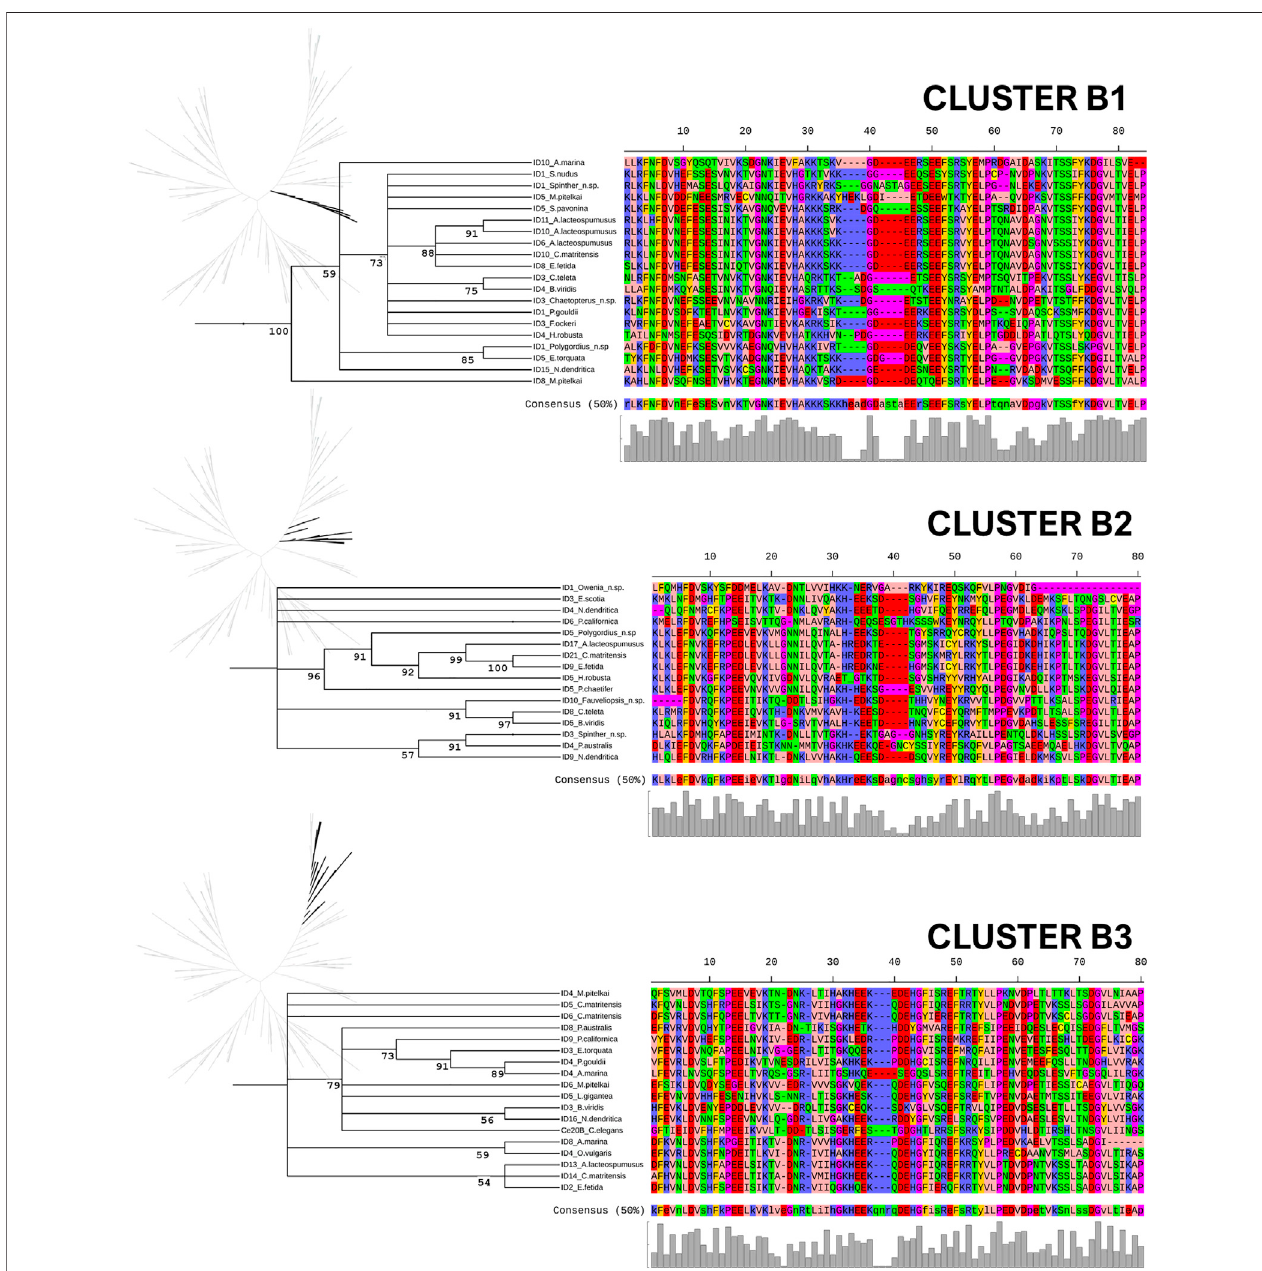
FIGURE6| ClustersB1,B2,andB3.MultiplesequencealignmentvisualizedonadendrogramobtainedfromtheBayesiantree,usingtheZappocoloringscheme. Theconsensussequence(at50%conservation)andresidueconservationwerecalculatedbyiTOL.Ontheleft,theunrootedradialMLcladograms,inwhicheachcluster is highlighted. The posterior probability values are included as percentages in the